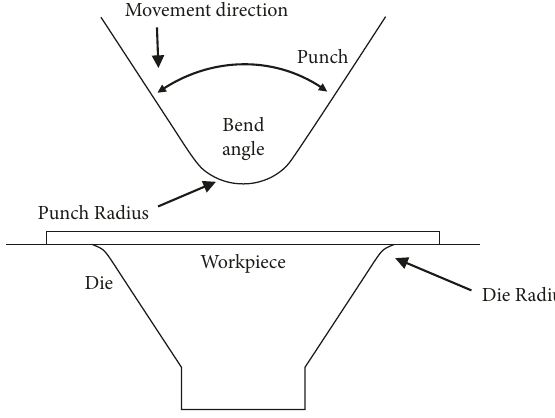
Figure 1: V-die bending model.